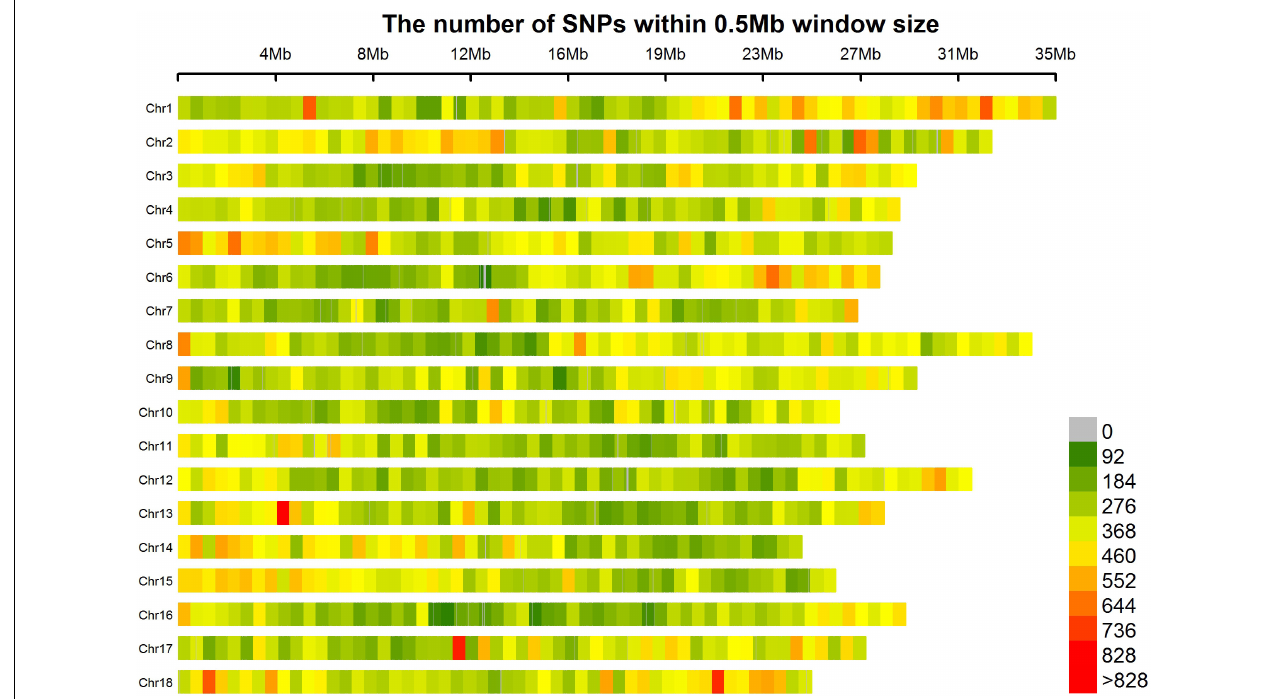
FIGURE 2 | SNP distributions on 18 chromosomes of cassava. Horizontal axis displays the chromosome length; 0–828 legend insert indicates the SNP density.